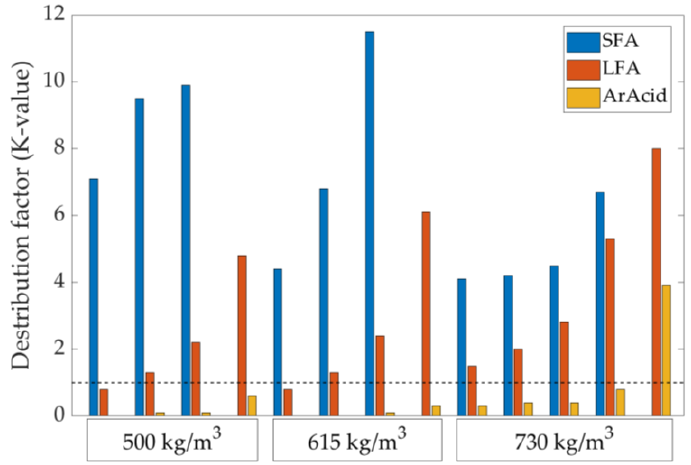
Figure 8. Variation of K-values with extraction progression (left to right) of different types of acids: short chain fatty acids (SFAs); long chain fatty acids (LFAs); aromatic acids (ArAcid). Extraction temperature: 120 ◦ C. Three different solvent densities [127].